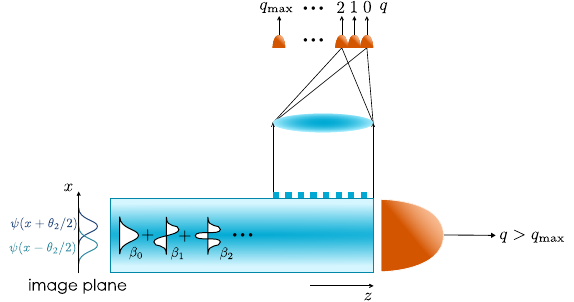
FIG. 4. A multimode-waveguide SPADE with a grating output coupler and far-field photon counting. The photon counter at the end of the multimode waveguide captures any remaining photon in the higher-order or leaky modes.